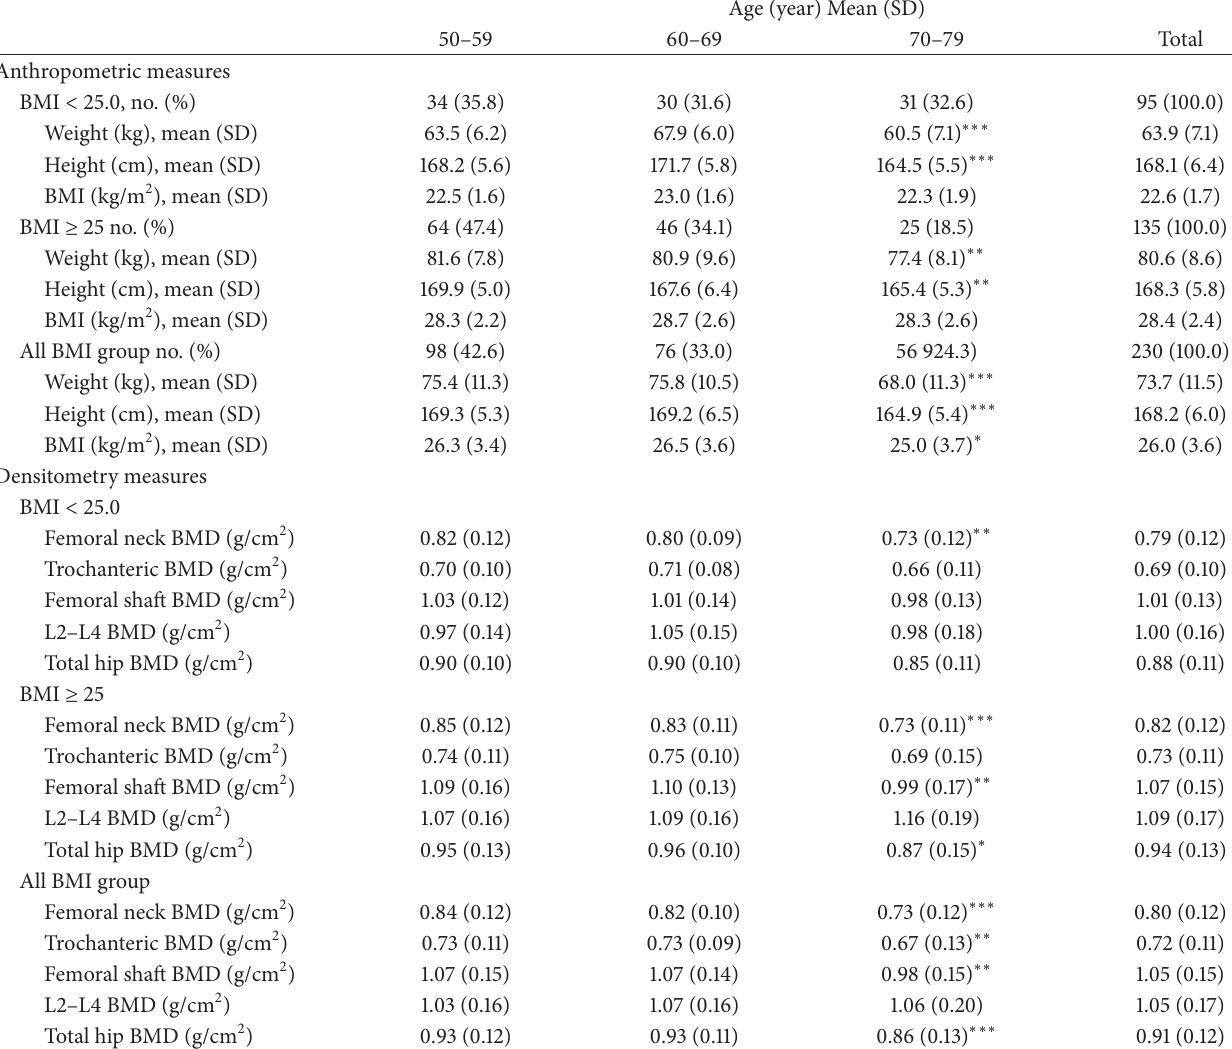
Table 2: Anthropometric and densitometric measures of men aged 50 years and older by age group and BMI classification.